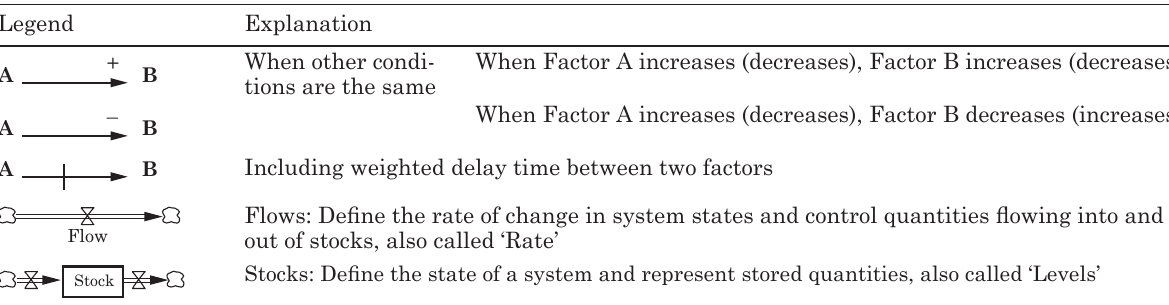
Fig. 2. Legends in the causal loop diagrams (Sterman 2000; Park et al. 2010)